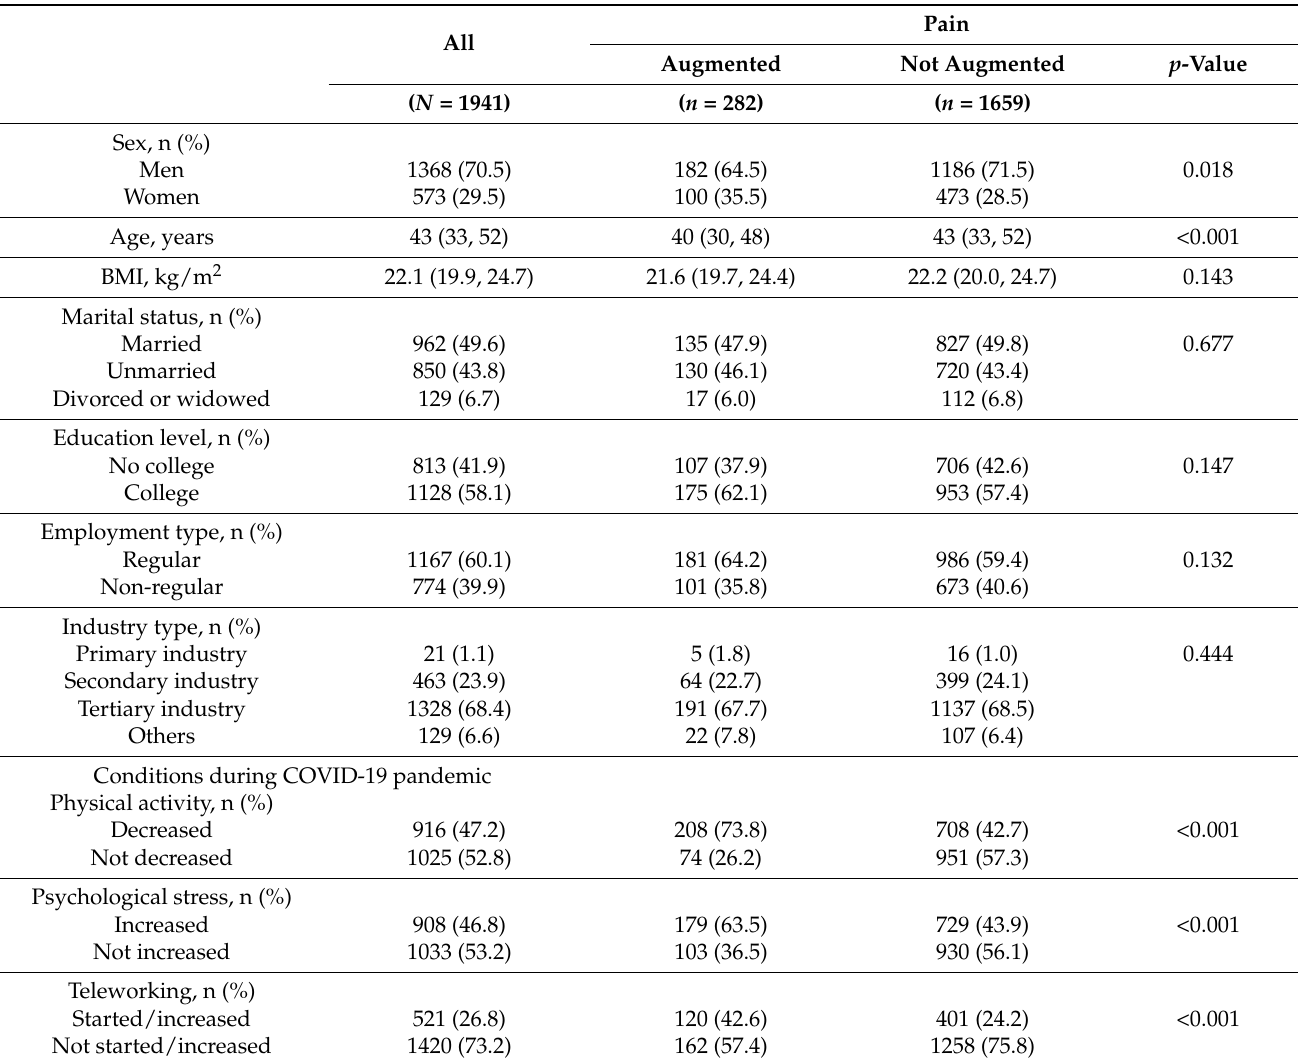
Table 1. Characteristics of the study participants.